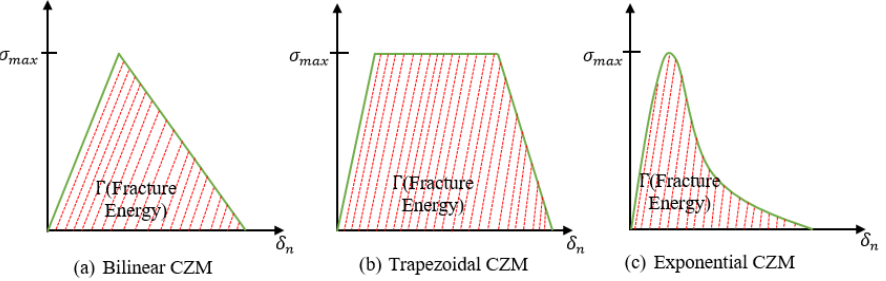
Figure 2. Typical cohesive zone models.